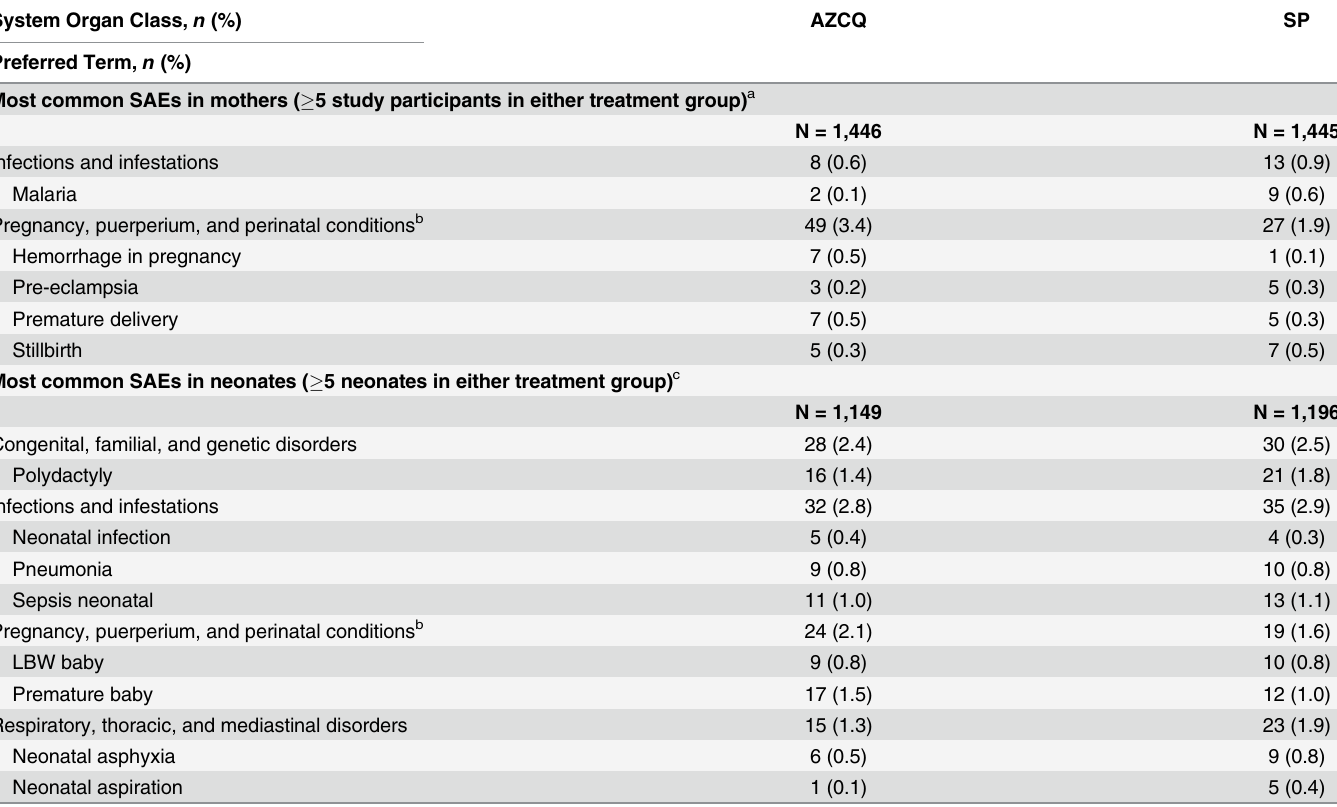
Table 5. Most common serious adverse events in the safety